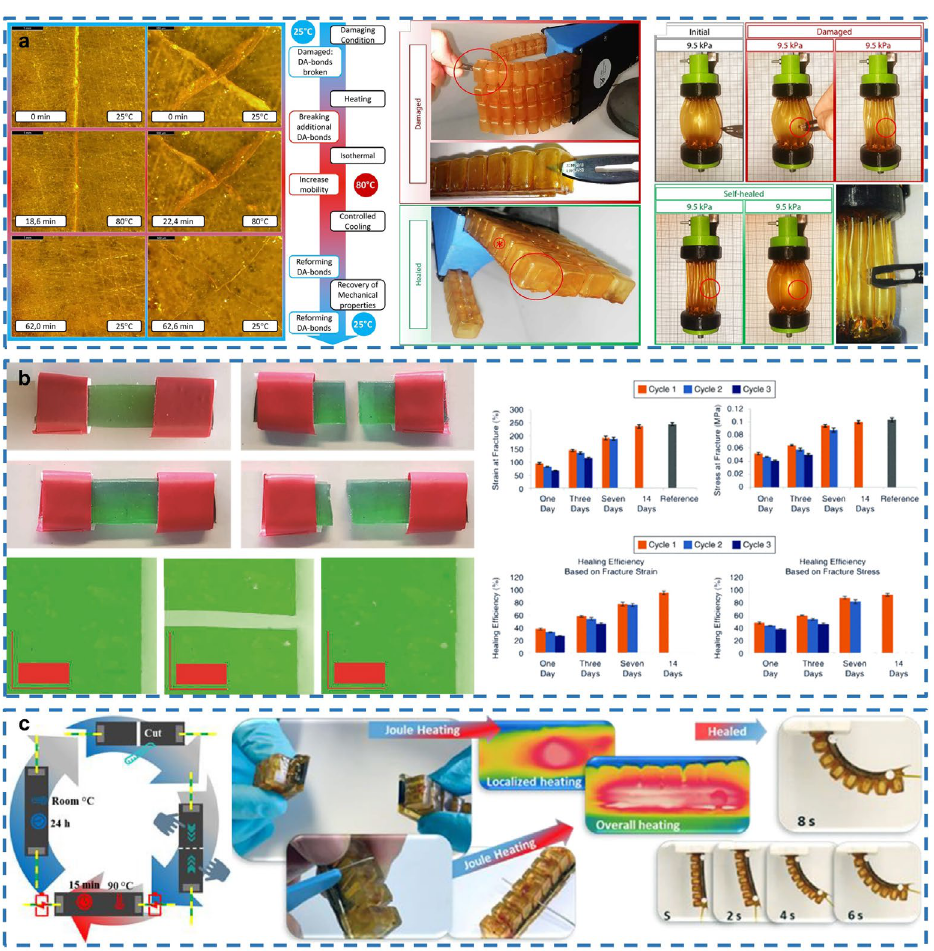
Figure 3. Self-healing soft robots. ( a ) Schematic of the self-healing cycle of DA polymers and validation of the self-healing ability in practice. Reprinted with permission from [112]. Copyright 2017, American Association for the Advancement of Science. ( b ) Testing autonomous healing at room temperature and the self-healing efficiencies. Reprinted with permission from [113]. Copyright 2020, IEEE. ( c ) A healable resistive-heater self-healing soft robot. Reprinted with permission from [114]. Copyright 2022, IEEE.